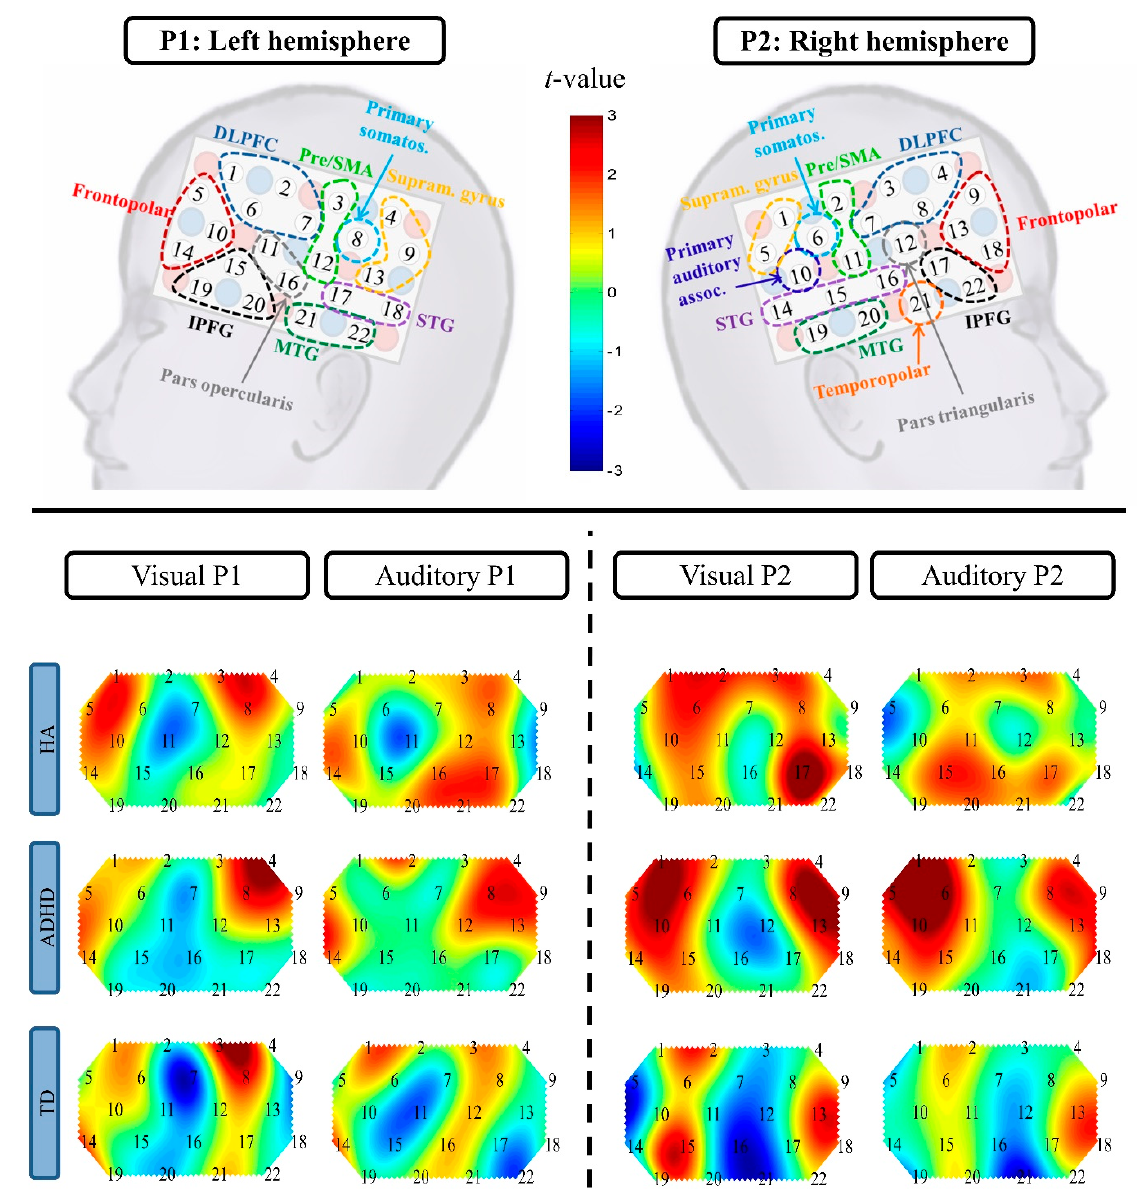
Figure 3. Heat maps ( t -maps) of the ∆ HbO contrast against baseline per group (HA, ADHD, TD) and condition (auditory, visual). The respective t-values can be found in the Table S2. Abbreviations: P, Probe set; DLPFC, dorsolateral prefrontal cortex; pre/SMA, pre-motor and supplementary motor area;